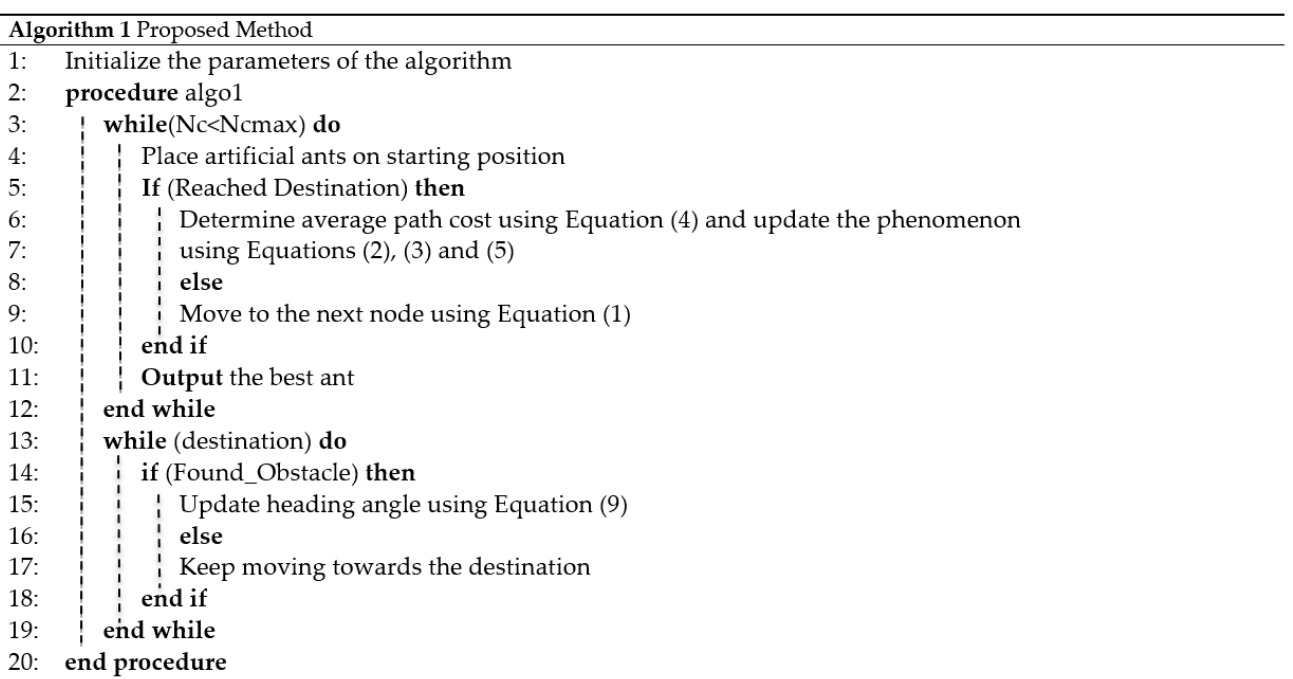
Algorithm 1 of the proposed method is detailed below;